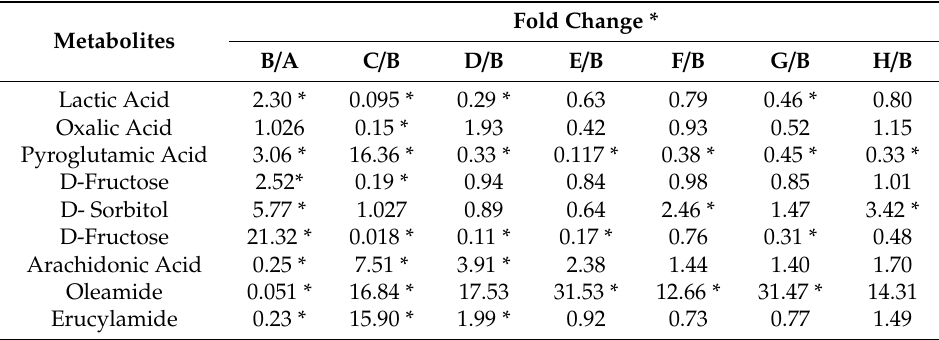
Supplementary Materials: The following are available online at www.mdpi.com/xxx/s1, Figure S1: Representative structures of identified compounds from n -BuOH extract of A. saligna ., Table S1: Gas chromatography-mass spectroscopy (GC-MS) identification of metabolites in rats’ sera based on its RI and MS spectral data.